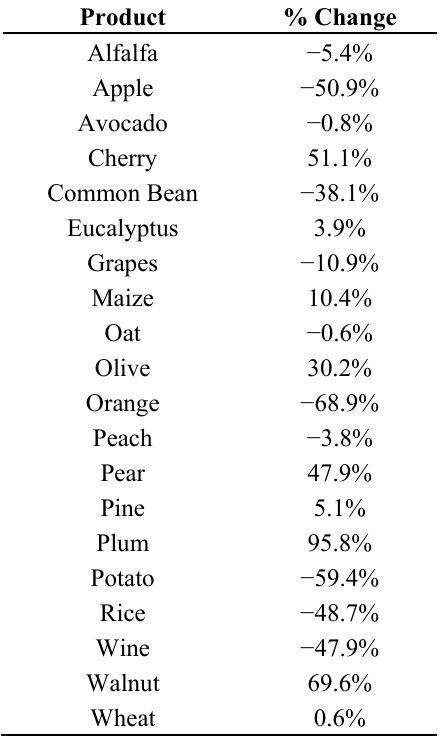
Table 3. Expected Changes in Demand Prices